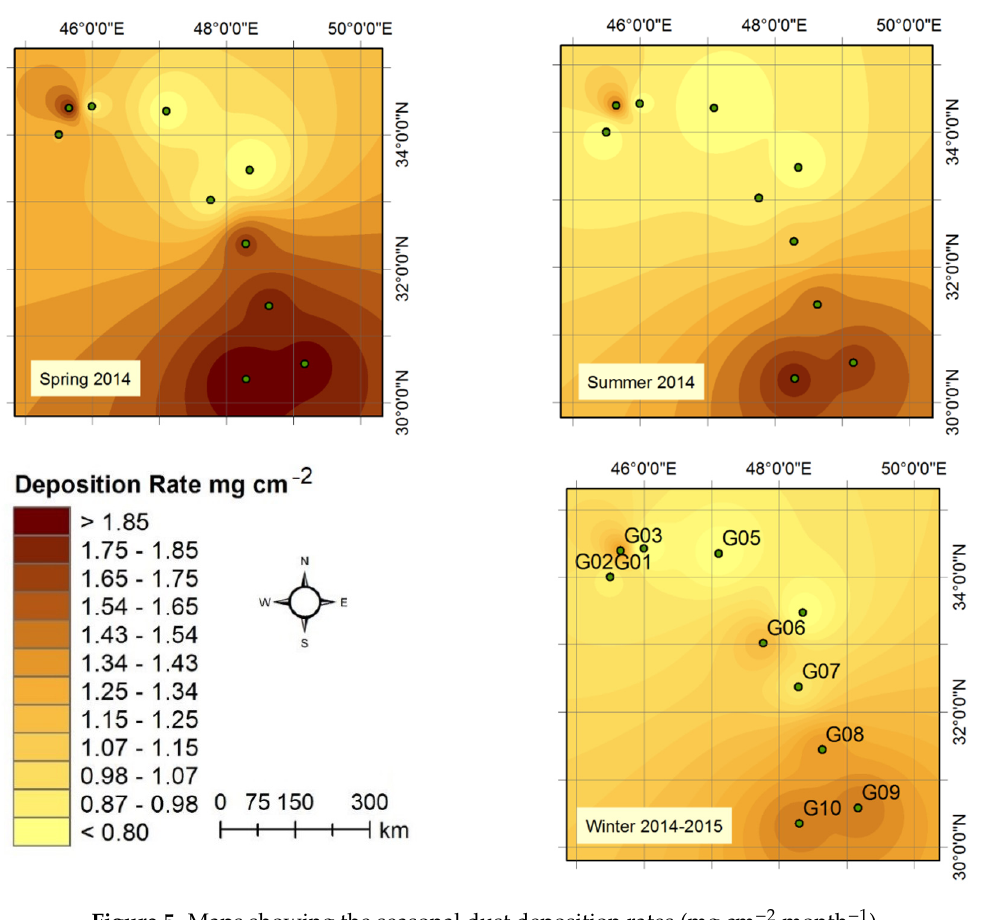
Figure 5. Maps showing the seasonal dust deposition rates (mg cm − 2 month − 1 ).